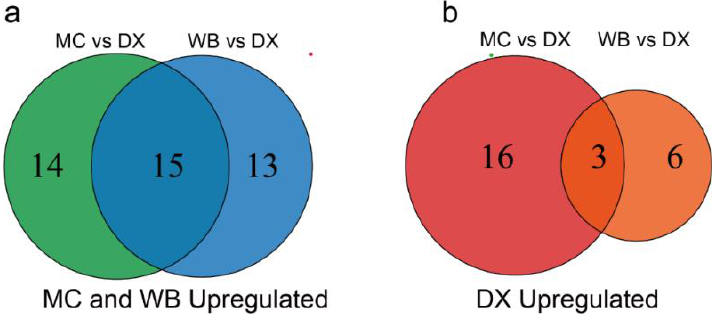
Figure A3. Numbers of up-regulated metabolites in MC, WB and DX. ( a ) The metabolites up-regulated by Maichong and Wubao. The circle on the left represents the number of metabolites up-regulated by Maichong, the circle on the right represents the number of metabolites up-regulated by Wubao, and the intersection is the number of metabolites up-regulated by the two orchards. ( b ) The number of metabolites up-regulated by Daxin. The circle on the left represents the number of metabolites up-regulated in Daxin when Maichong is compared to Daxin. The circle on the right represents the number of metabolites up-regulated in Daxin when Wubao is compared to Daxin. The intersection is the number of metabolites up-regulated in Daxin.